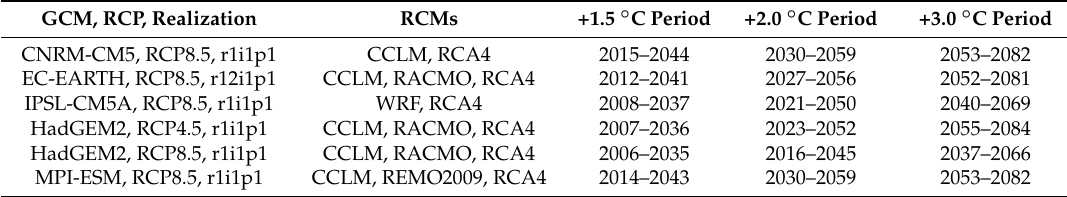
Table 2. Regional climate model (RCM)-general circulation model (GCM) combinations (16 in total) of the simulations used in this study, and the 30-year period centers under which the GCM shows a